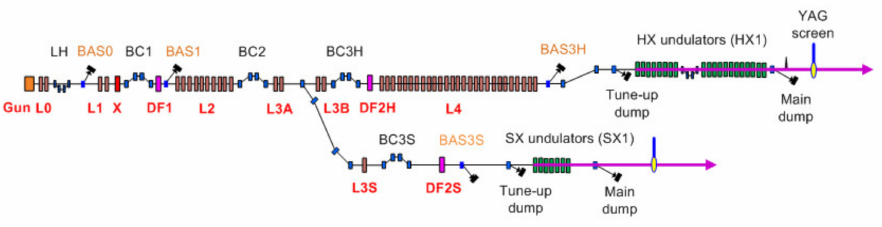
Figure 1. Schematic diagram of PAL-XFEL. L0, L1, L2, L3A, L3B, L4, L3S: acceleration sections; BC1, BC2, BC3H, and BC3S: magnetic bunch compressor chicanes, whose dipoles are rectangles in blue; BAS0, BAS1, BAS2, BAS3H, and BAS3S: beam analysis stations; LH: laser heater; X is an X-band linearizer cavity; DF1, DF2H, and DF2S: deflector cavity.